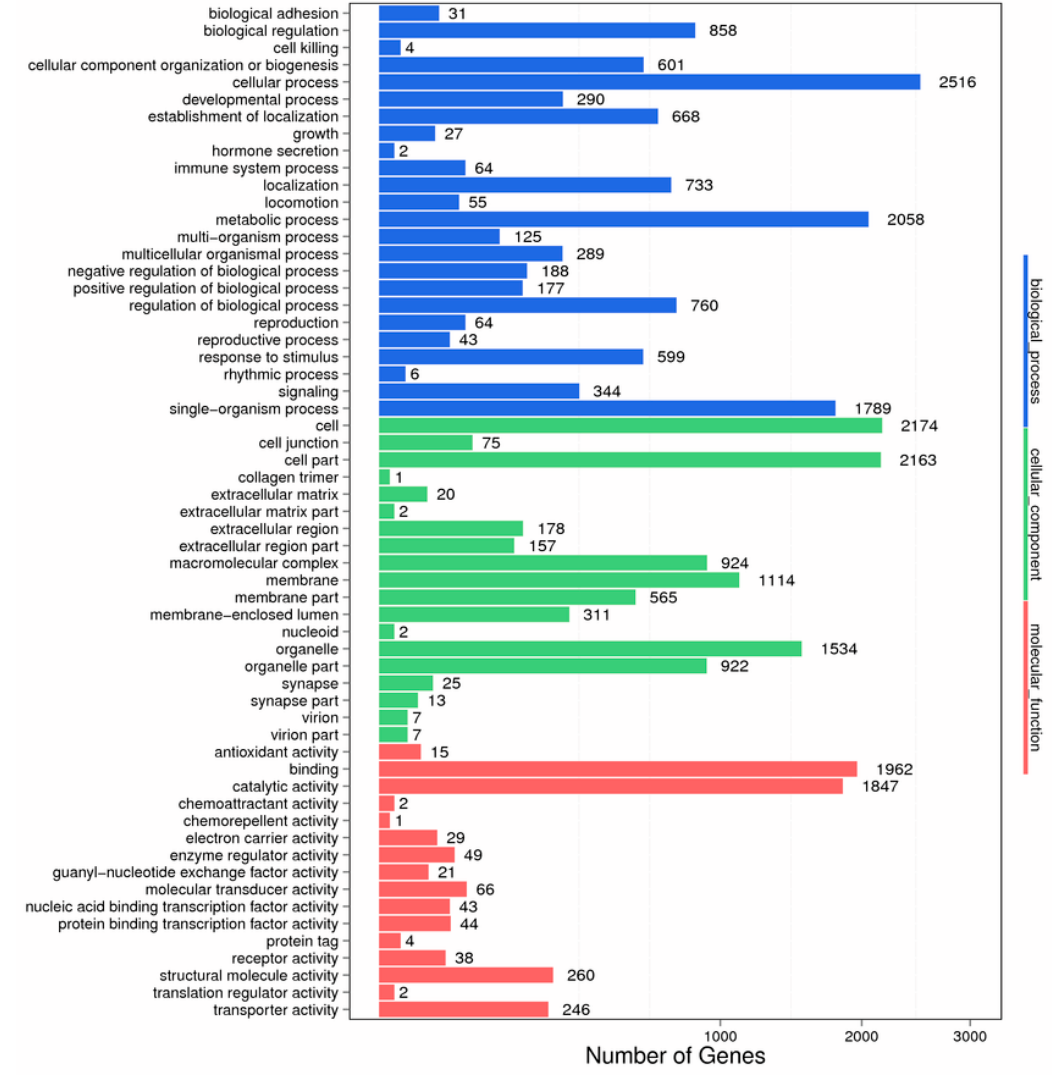
Figure 2. Gene Ontology (GO) annotation of all unigenes.